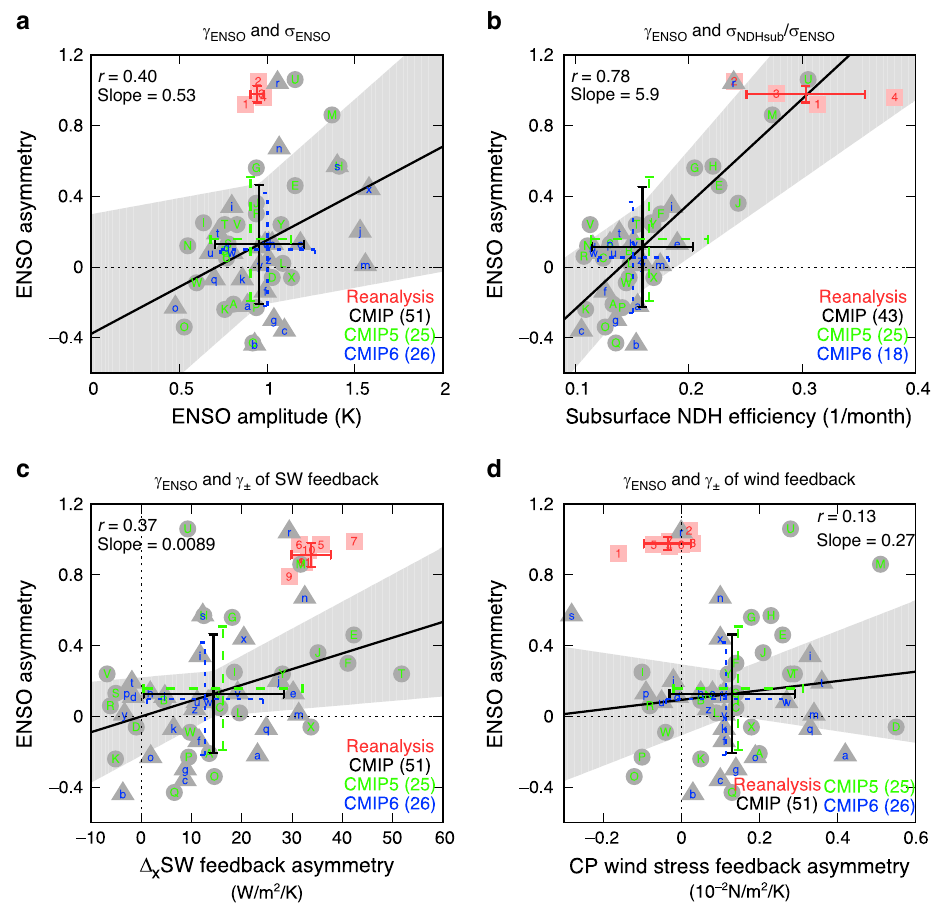
Fig. 2 ENSO asymmetry and nonlinear processes. Skewness of sea surface temperature (SST) anomalies in the Niño-3 region as functions of ENSO amplitude ( a ), the ef fi ciency of subsurface nonlinear dynamical heating ( b ), feedback asymmetry of the zonal contrast ( Δ x ; 140° – 170°E minus 140° – 170° W, 5°S – 5°N) of shortwave anomalies ( c ), and feedback asymmetry of central-Paci fi c (CP; 150°E – 120°W, 5°S – 5°N) zonal wind stress anomalies ( d ). In ( c , d ) feedback asymmetry ( γ ± ) is the difference between regression coef fi cients for positive and negative Niño-3 SST anomalies. Error bars denote the one standard deviation range for all models (black), CMIP5 (green with circles), CMIP6 (blue with triangles), and reanalysis (red with squares). In each bracket, the number of available models is indicated. The linear fi tting lines for all the models are shown with shading for the 95% con fi dence ranges of slopes and intercepts.